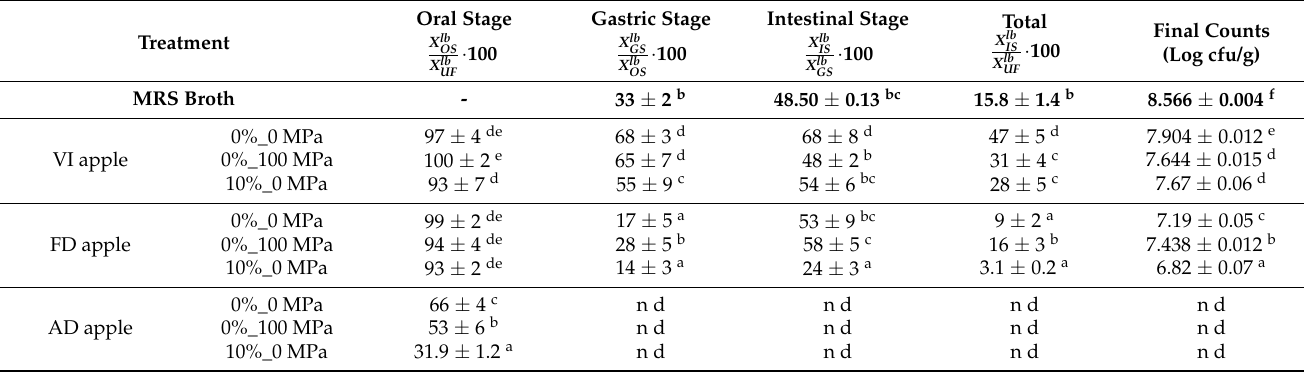
abcde different superscripts in the same column indicate statistically significant differences ( p -value < 0.05). X lb undigested food (cfu/g dw); X lb OS are the colony counts at the end of the oral stage (cfu/g dw); X lb GS are the colony counts at the end of the gastric stage (cfu/g dw); and X lb IS are the colony counts at the end of the intestinal stage (cfu/g